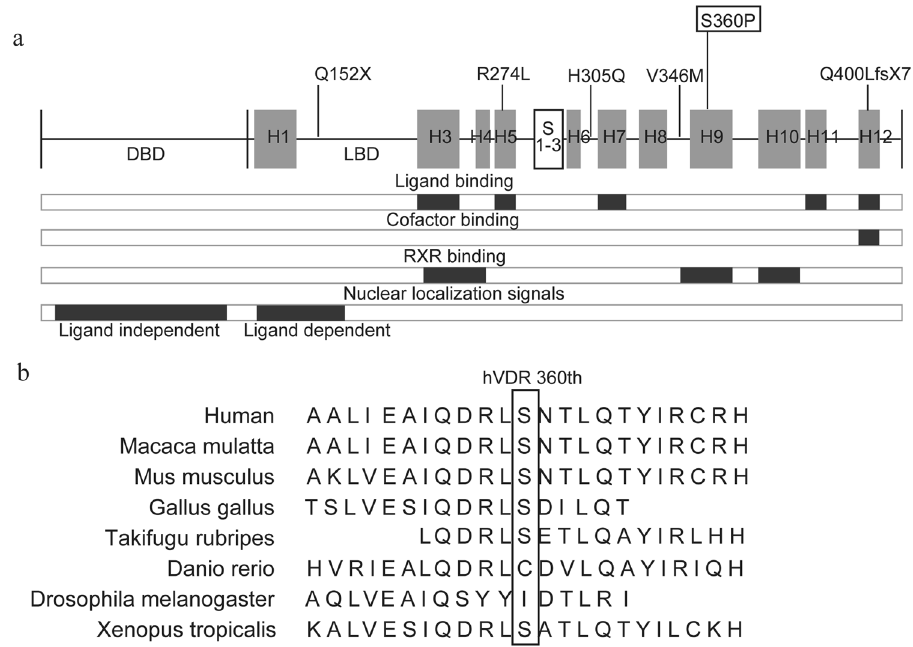
Figure 4. Functional domains of the VDR protein and homologues of the 360 th residue. ( a ) Functional domain chart of the VDR protein. Gray boxes represent helices of the ligand-binding domain (LBD). Each mutant is exhibited on each location; Q152X, which is a nonsense mutation on the hinge of the VDR, missing the LBD 21 , R274L and H305Q, missense mutations in the LBD found in patients without alopecia 21, 22 , V346M, a missense mutation in the LBD found in patients with alopecia 20 , Q400LfsX7, a frameshift mutation without alopecia 29 , and S360P, the novel missense mutation we reported in this study. Bars below the protein chart show functional domains based on previous reports of ligand binding, cofactor binding, RXR binding, and nuclear localization signals 4, 31 . ( b ) Homologs of the 360 th residue of the VDR among species. Serine, the 360 th residue of human VDR, is not a highly conserved